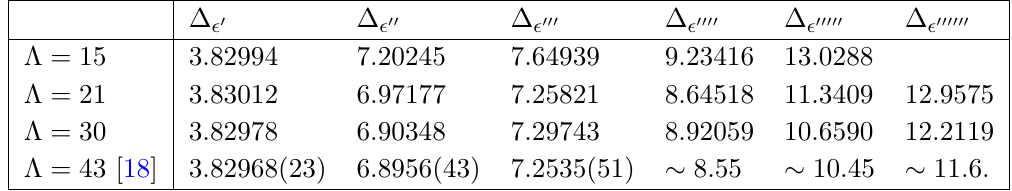
Table 7 . Zeros of the functional for Z 2 -even scalars in d = 3 at different Λ . The first three lines were computed for the specific point ( ∆ The last line corresponds to the averaged value of